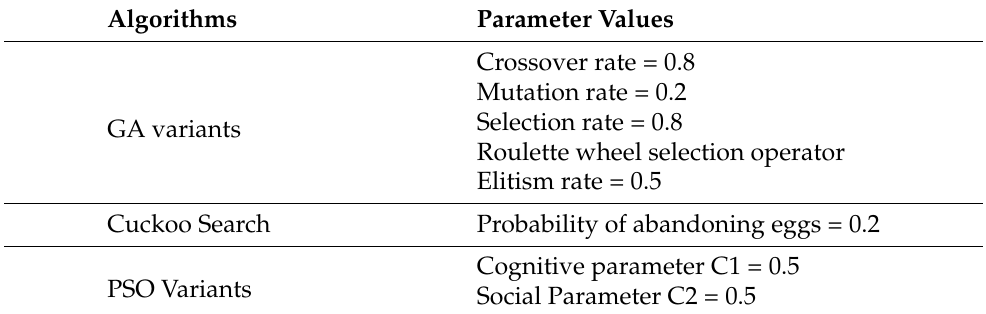
Table 2. Parameter configurations of the algorithms compared in our